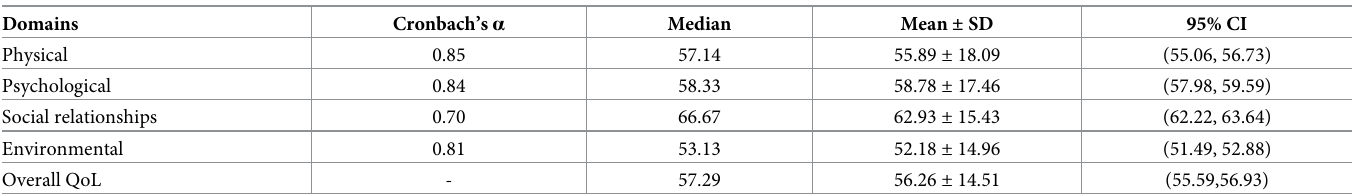
Table 3. Quality of life descriptive results among chronic disease patients in Amhara region, Ethiopia (n = 1, 815), 2021. Domains